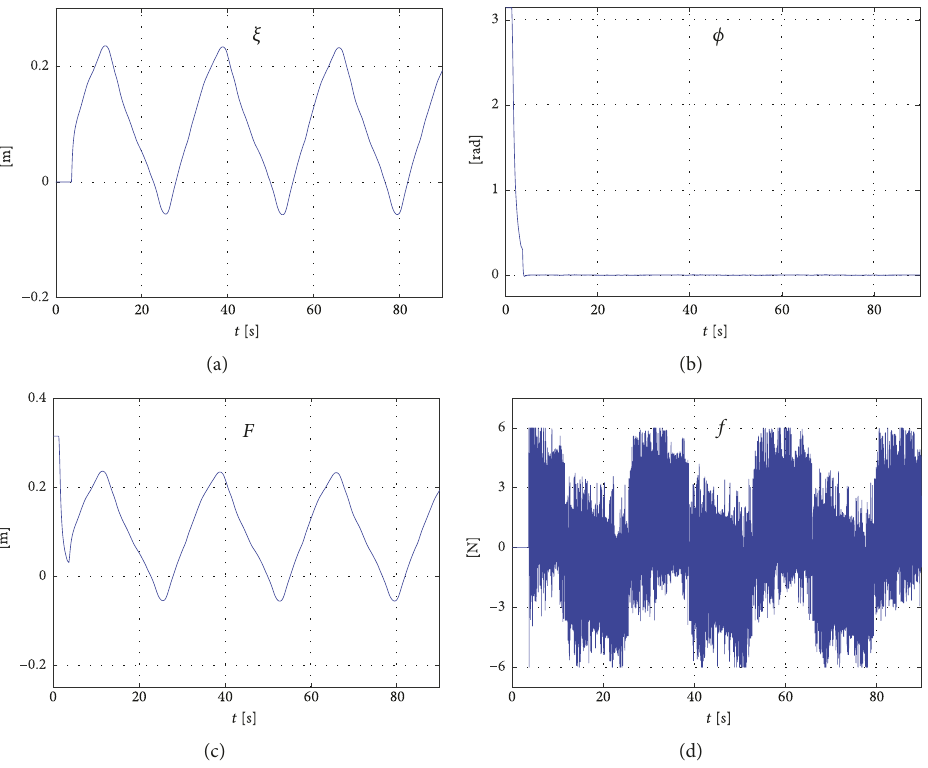
Figure 12: Experimental results when |𝐺(𝑗𝜔 𝜎 )| = 40 and 𝜔 𝜎 = 6 rad / s.